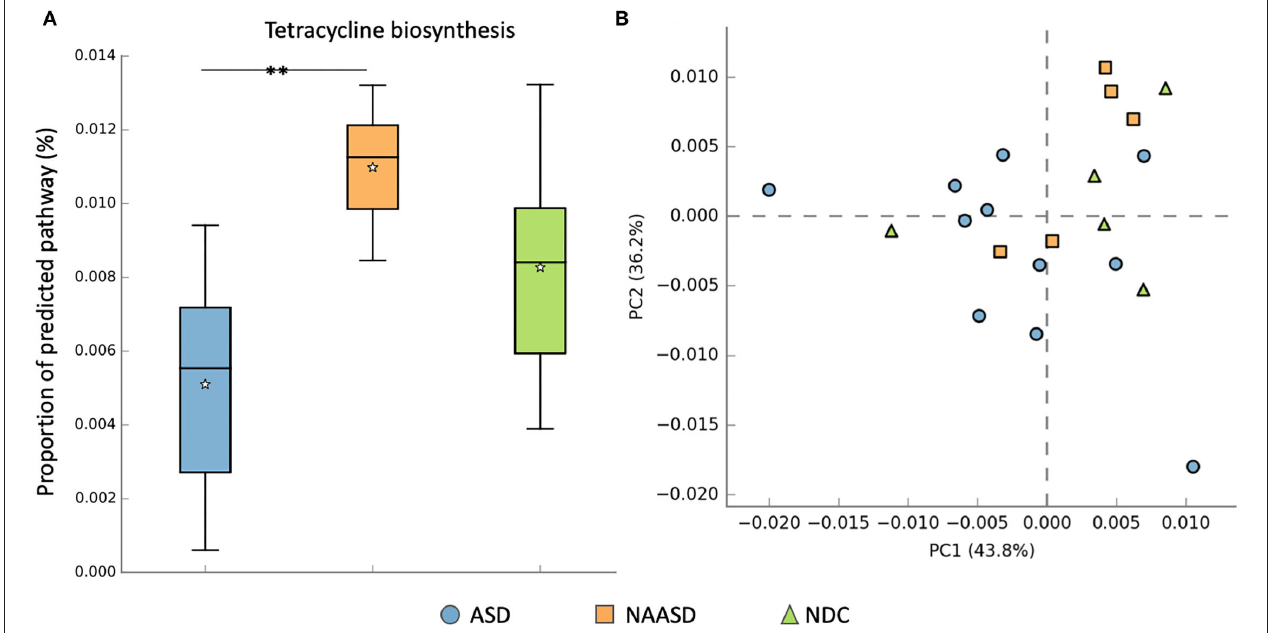
FIGURE 6 | Differences in metabolic pathways between CSS groups. (A) Proportion of the predicted pathway tetracycline biosynthesis among CSS groups tested using Welch’s t -test after FDR correction. (B) PCA distribution of predicted core metabolic pathways by CSS group. The * symbol indicates the significant difference after FDR correction p =